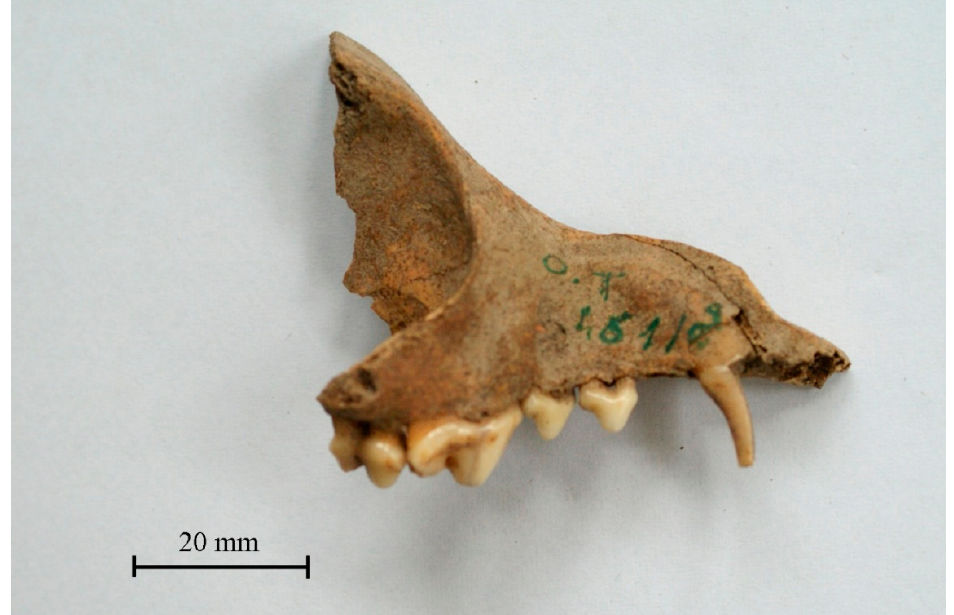
Figure 1. The dog’s skull fragment, Wrocław Cathedral Island, Katedralna 4 Street, according to [14]. Reproduced with permission from A. Chrószcz, Wratislavia Antiqua; published by Instytut Archeologii UWr, 2012.